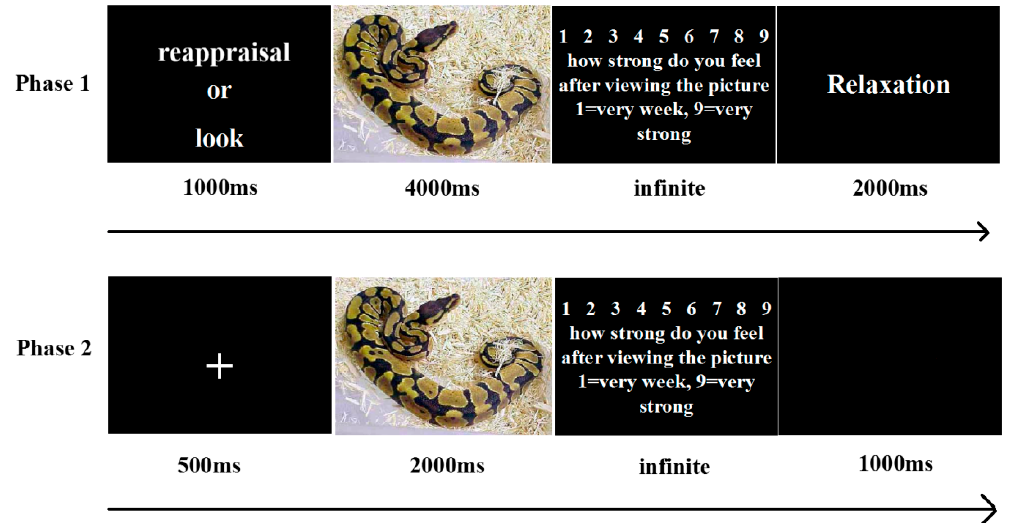
Figure 1. Procedure of the Figure 1 . Procedure of the Study.